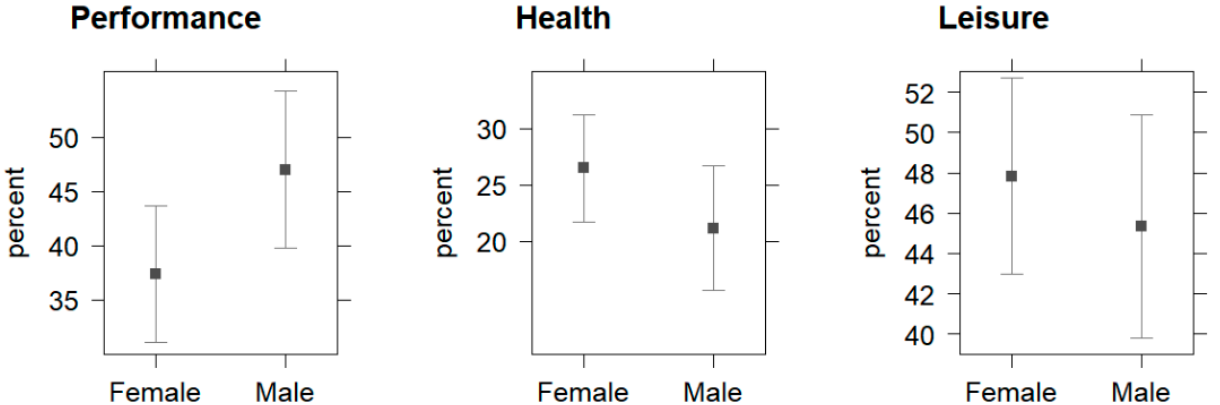
Figure 2. Effect plots with 95%-CI displaying the differences between female and male running ex- ercise/racing motives ( n = 231): performance, health, and leisure. Note . 95%-CIs were computed us- ing the multivariate regression analyses (Wald